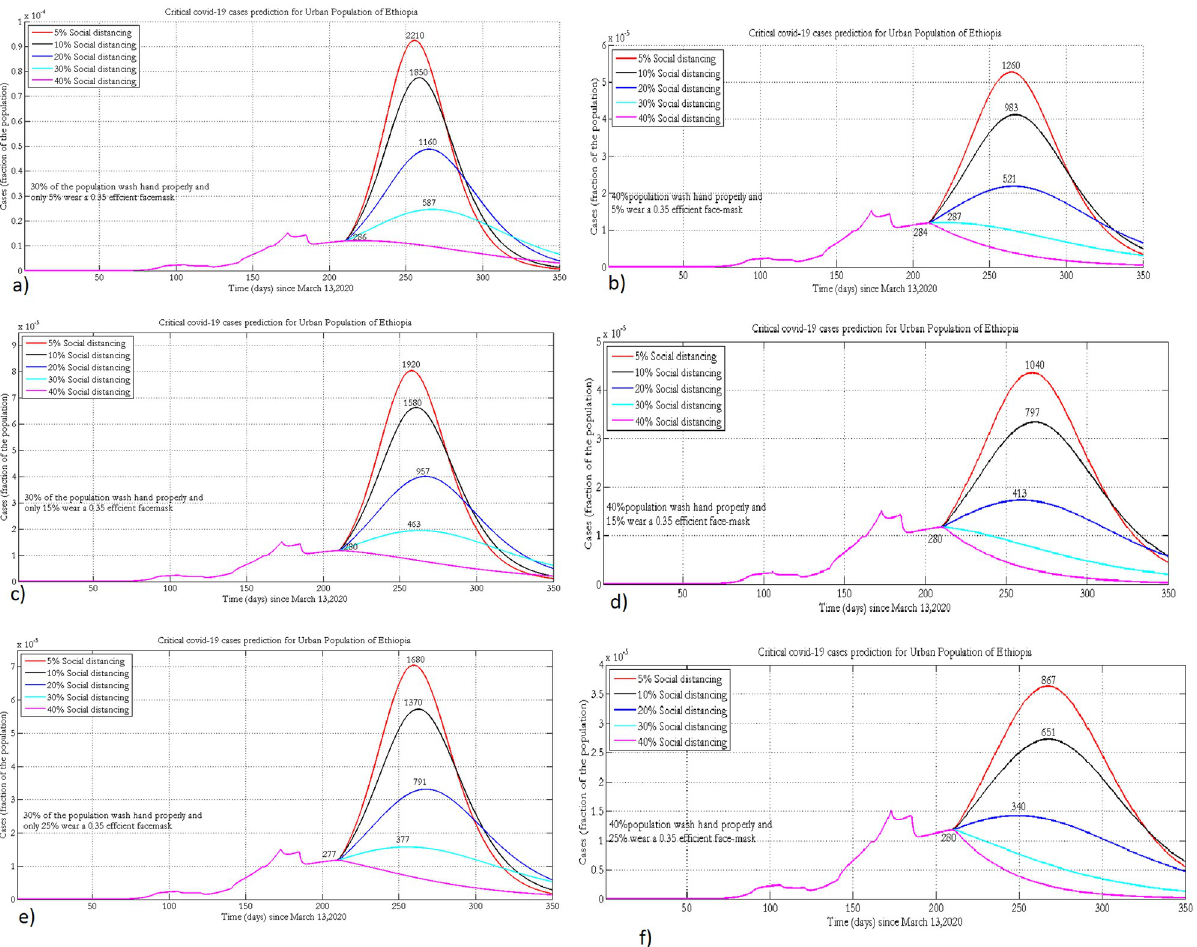
Fig 6. Projected number of the urban population who will need intensive care when 30% or 40% practice hand washing and 5% (a, b), 15% (c, d) or 25% (e, f) of the population wear face masks, with 35%